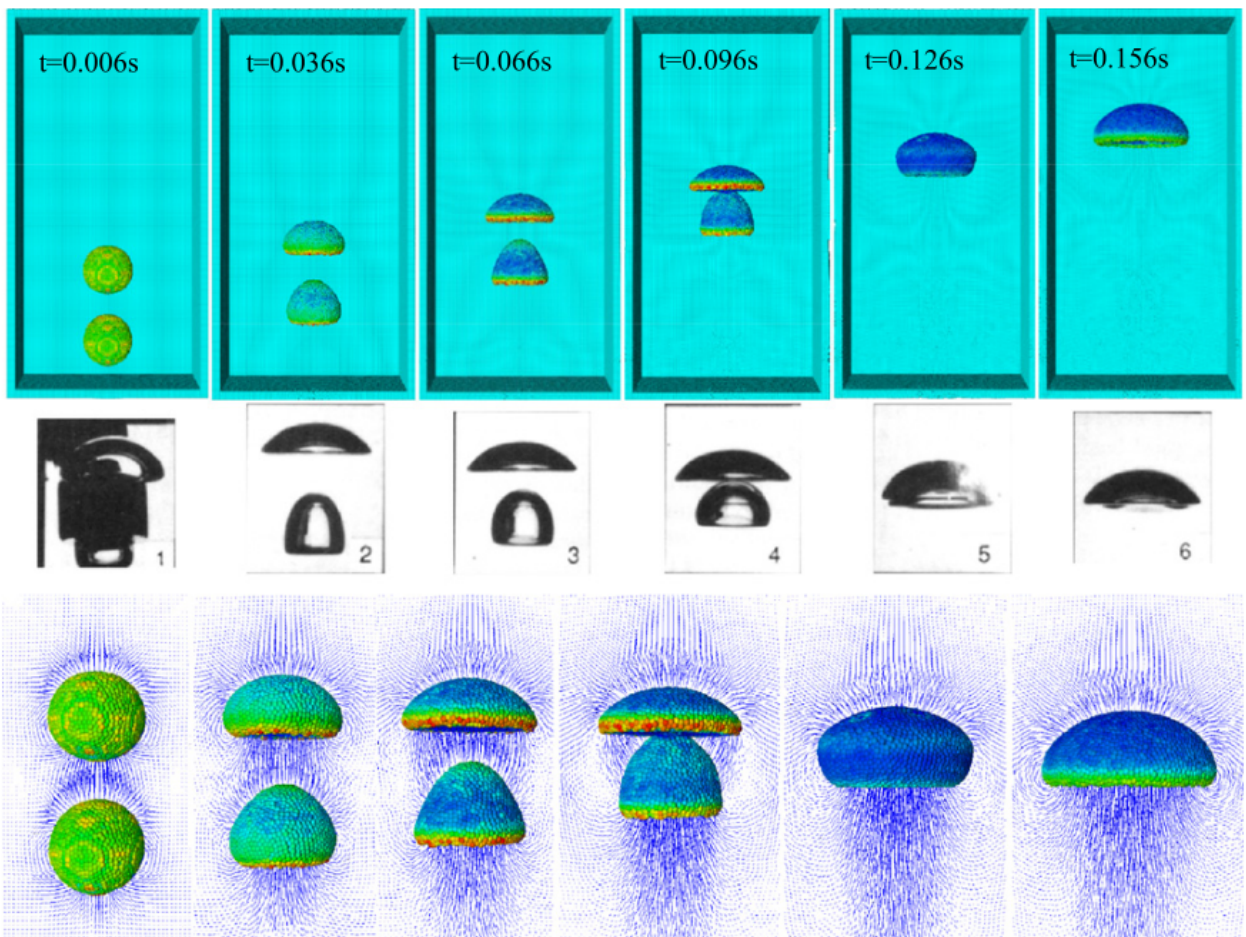
Figure 12. Comparison of SPH results (based on the SPH model with summation-based density, top and bottom) for the fusion of two bubbles with experimental results (middle)